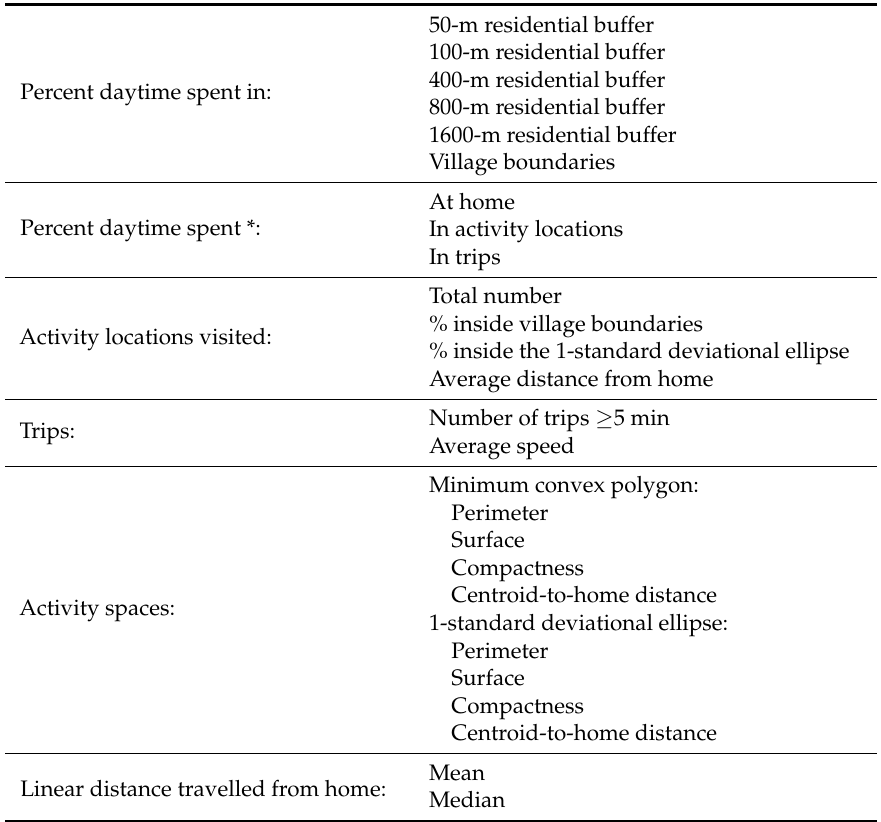
Table 1. Indicators of daytime